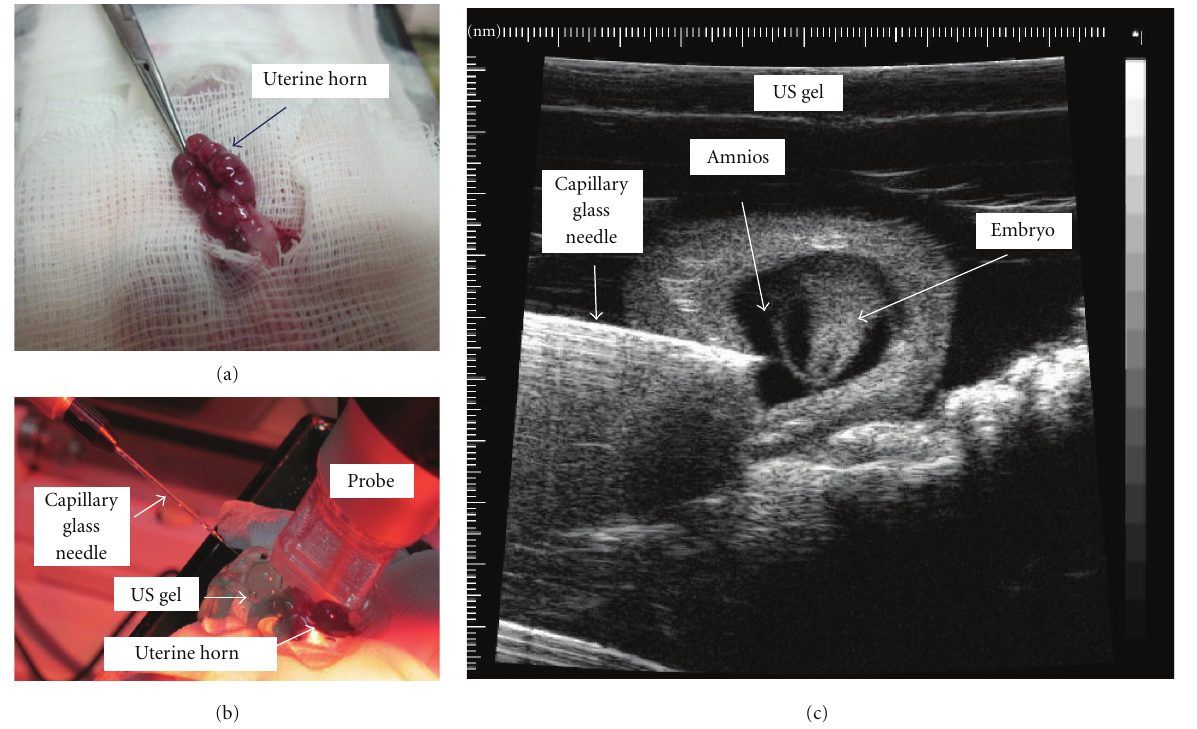
Figure 7: In utero microinjection: laparoscopy along the linea alba. The uterine horns are gently exteriorized to record implantation sites and simply positioned on sterile gauze and covered with sterile acoustic gel (a). A 40Mhz probe is used to image in real time the embryos, and the microinjection is performed by an automatic microinjector equipped with a capillary glass needle. The needle is advanced with the use a micromanipulator under echo guidance until the needle tip is in the desired location (b). UBM images of a capillary glass needle advanced under echo guidance until the needle tip is in the amnions